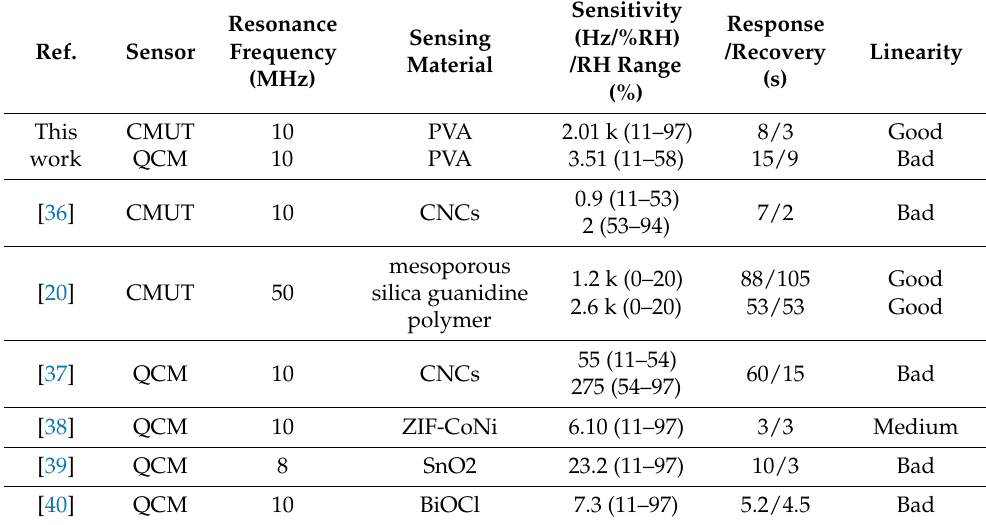
Table 1. Comparison between the humidity sensors in this work and reported gravimetric humidity sensors.